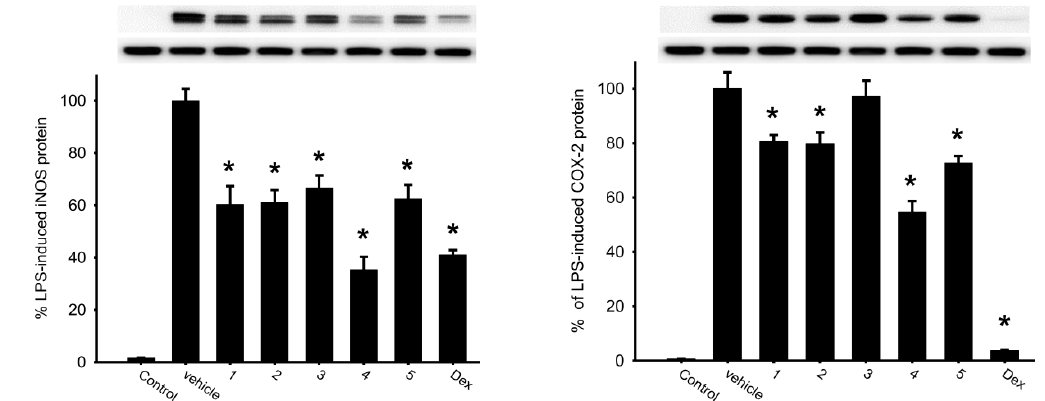
Figure 5. Western blotting showed that briarane 4 downregulated the expression of iNOS and COX-2. Data were normalized to the cells treated with LPS only, and cells treated with dexamethasone (Dex; 10 µ M) were used as a positive control. Data are expressed as the mean ± SEM ( n = 2~4). * Significantly different from cells treated with LPS ( p < 0.05). Table 3. Effects of briaranes 1 – 5 on LPS-induced pro-inflammatory iNOS and COX-2 protein expression in macrophages.